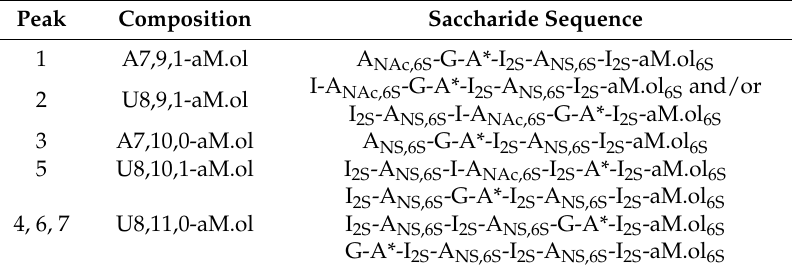
Table 3. Structure assignment of species detected in octa-HA